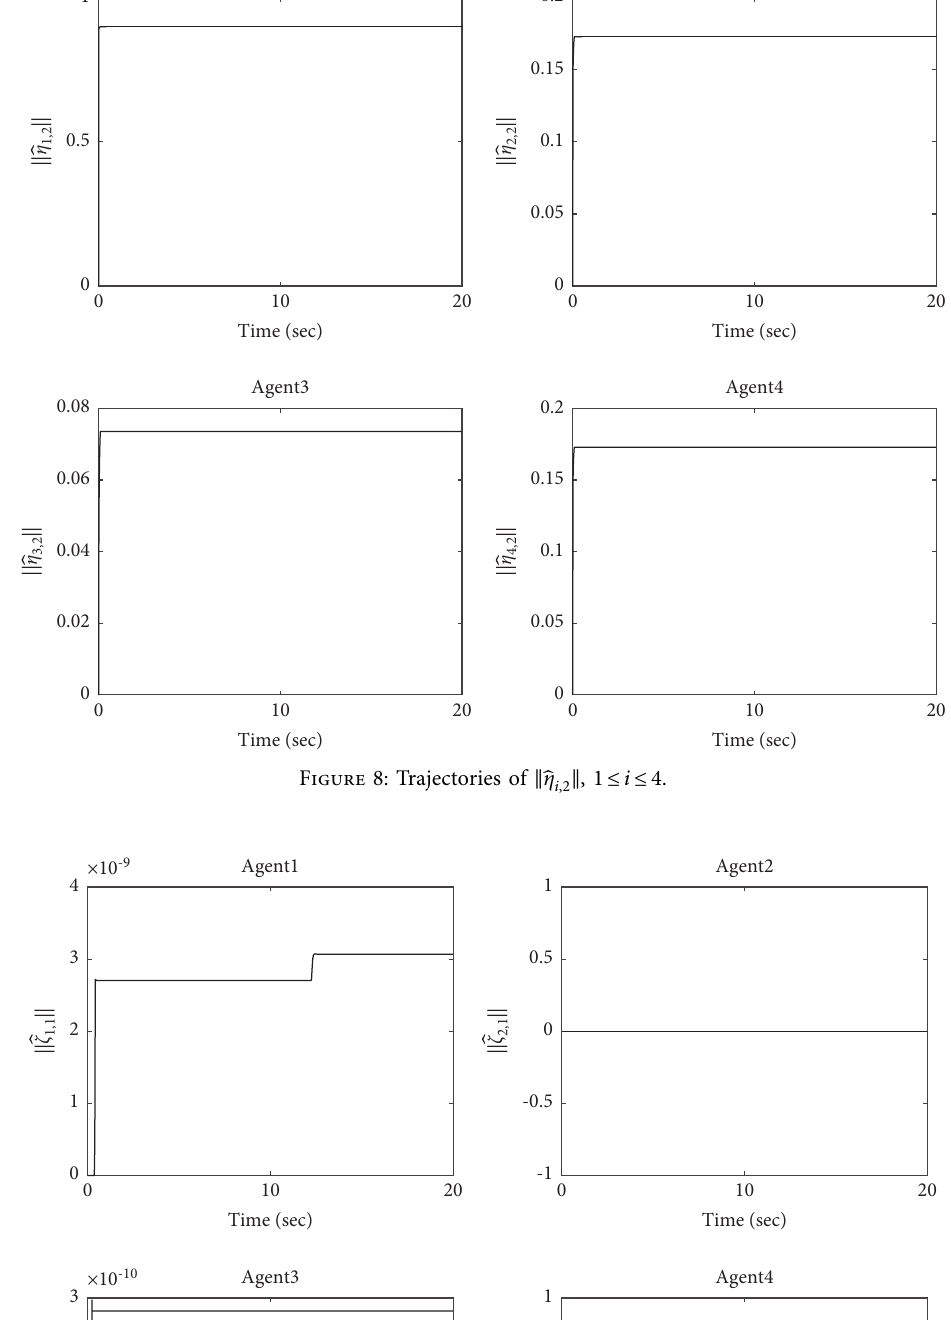
Figure 9: Trajectories of ‖ 􏽢 ζ